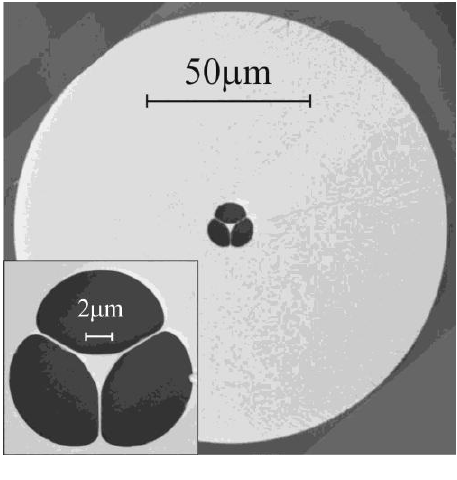
Figure 2. Scanning Electron Microscope (SEM) image of the soft glass MOF used for these experiments. The central, structured region of the fiber was made from F2HT